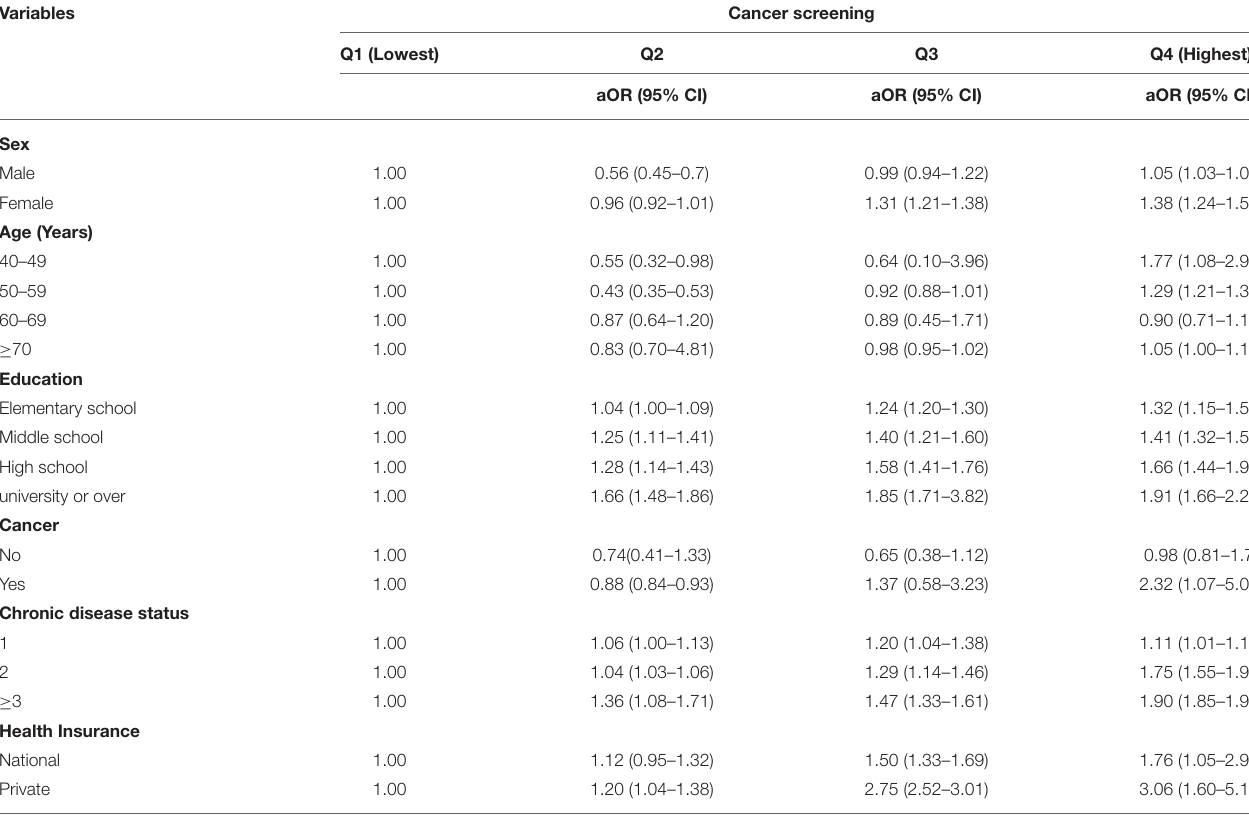
TABLE 4 | Subgroup analysis of associations between cancer screening and household income.